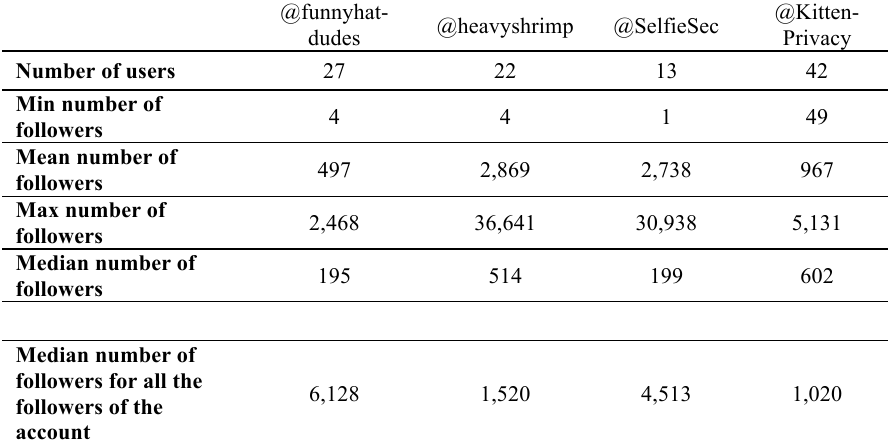
Table 8. The statistics of the numbers of followers for the users who had retweeted or replied to case account